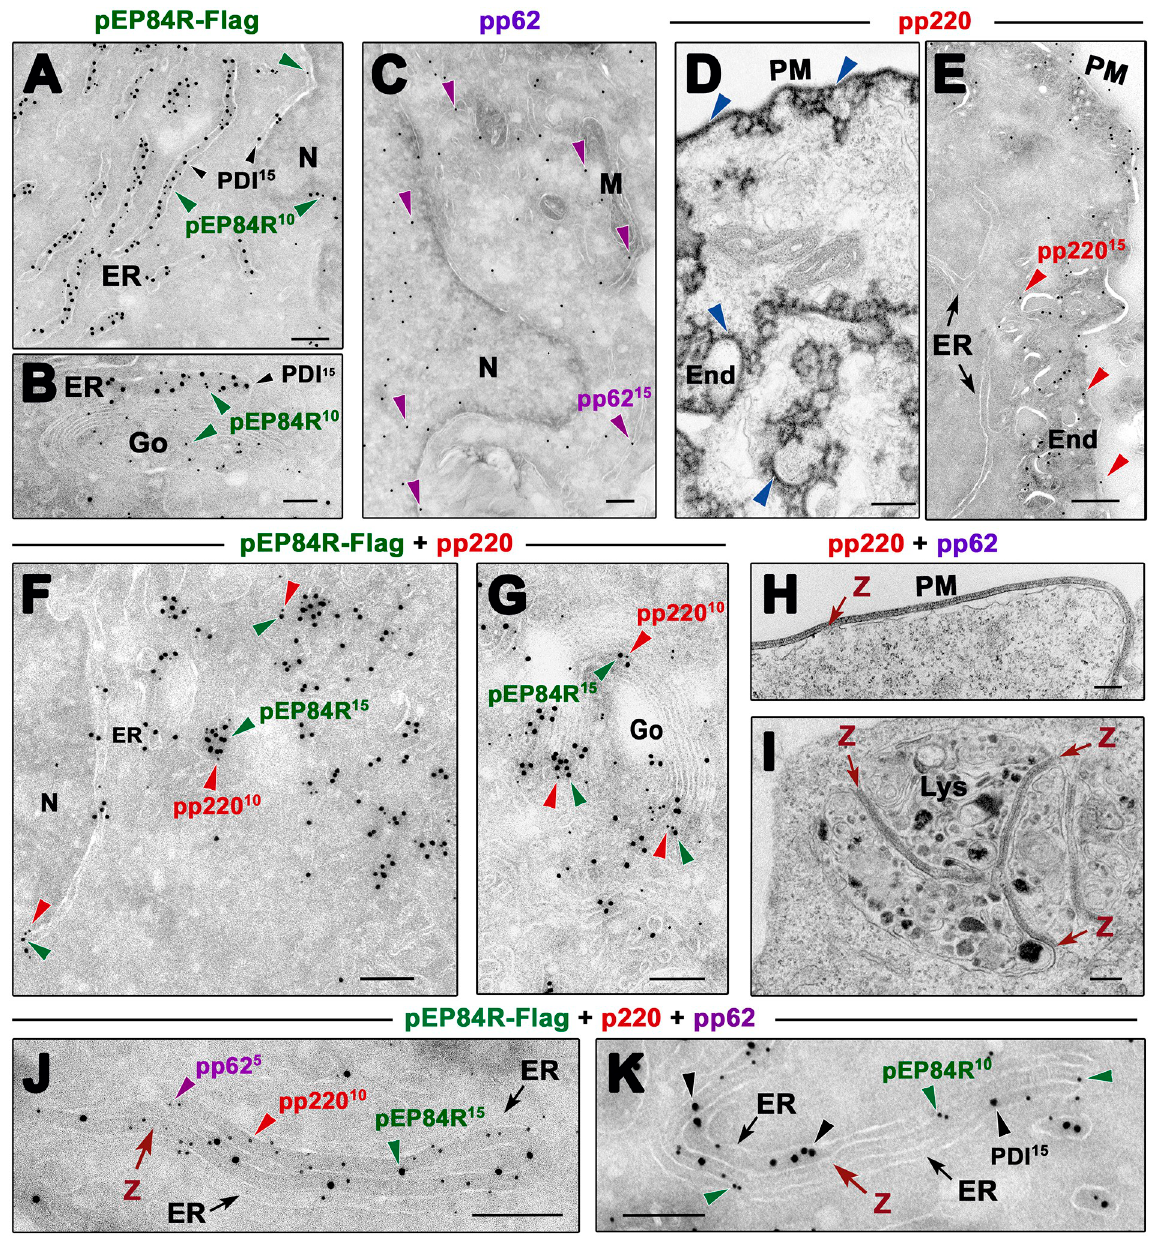
Fig 6. Protein pEP84R guides ER membrane targeting of pp220 and pp62 precursors. Transfected Cos cells expressing pEP84R-Flag, pp220 and pp62 individually or in combination, were fixed and processed for cryosectioning and immunogold labeling (A, B, C, E, F, G, J and K) or for conventional epoxy resin embedding (D, E, H and I) . (A, B) Double-labeling of pEP84R-Flag-expressing cells with rabbit anti-pEP84R (10-nm gold, green arrowheads) and mouse mAb anti-PDI (15 nm, black arrowheads) antibodies showing colocalization at ER (A, B) , including the nuclear envelope, as well as Golgi (Go) membranes (B) . (C) Immunostaining of pp62-expressing cells with a rabbit anti-pp62/p35 antibody (10-nm gold, purple arrowheads) reveals specific labeling at nucleus and cytoplasmic membranes. (D) Transfected polyprotein pp220 assembles into electron-dense coats (blue arrowheads) under the PM or surrounding cytoplasmic endosome (End) and lysosomes. (E) Immunolabeling of membrane-bound pp220 coats with an anti-pp220/p34 antibody (15-nm gold, red arrowheads). (F-G) Double labeling for pEP84R (10 nm, green arrowheads) and pp220 (15 nm, red arrowheads) in co-transfected cells. Note colocalization at the nuclear envelope (F) , Golgi membranes (Go) as well as perinuclear vesicles and cisternae (F-G) that probably belong to ER and Golgi networks. (H-I) Zipper (z) structures in cells co-expressing polyproteins pp220 and pp62. Note that these core shell-like structures are attached to the cytosolic face of the PM (H) as well as endosomal-lysosomal (Lys) membranes (I) . Triple immunogold labeling of ER-associated zippers with rabbit anti-pEP84R (15 nm, green arrowheads), rat anti-pp220 (10 nm, red arrowheads) and mouse anti-pp62 (5 nm, purple arrowheads) antibodies. (J) Double labeling with rabbit anti-pEP84R (10 nm, green arrowheads) and mouse anti-PDI (15 nm, black arrowheads) antibodies of ER-associated zippers (z) assembled in cells co-expressing pEP84R-Flag, pp200 and pp62. Bars, 200 nm. https://doi.org/10.1371/journal.ppat.1011136.g006 PLOS Pathogens| https://doi.org/10.1371/journal.ppat.1011136 January30, 2023 12 /